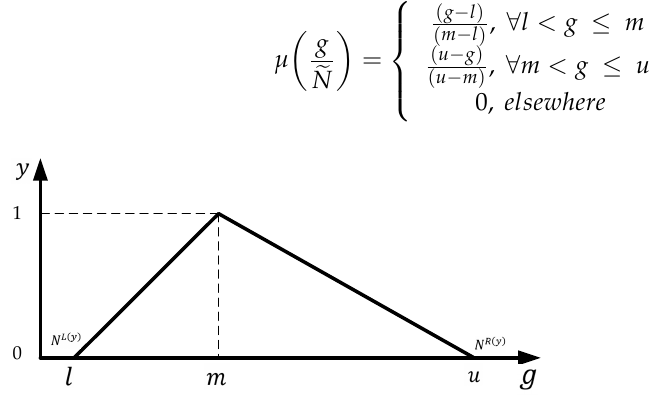
Figure 2. TFN membership function.